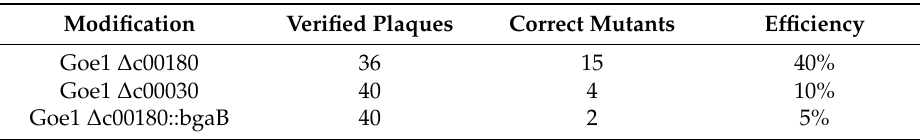
Table 2. Modification efficiency of